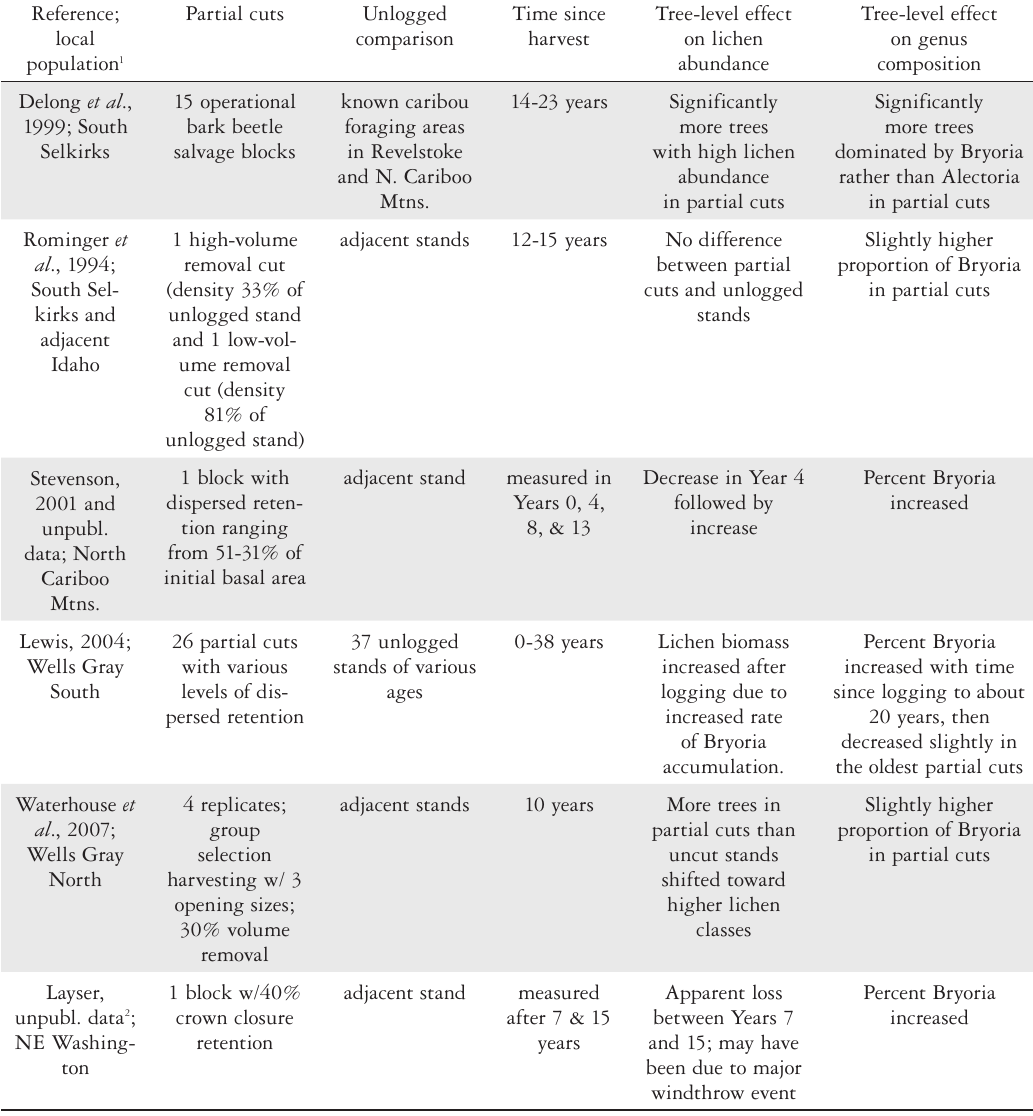
Table 1. Summary of effects of partial cutting on abundance and genus composition of arboreal forage lichens on residual